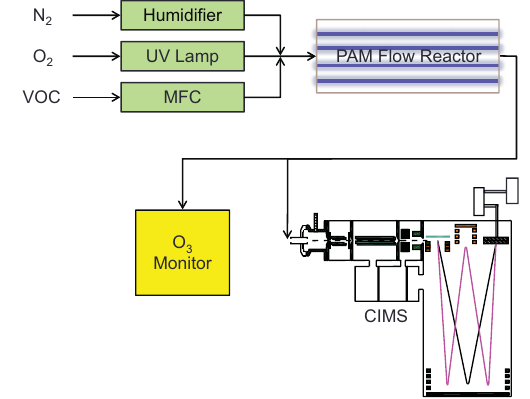
Figure 1. Schematic of the experimental setup. CIMS diagram adapted from Fig. 2 of Yatavelli et al. (2012).